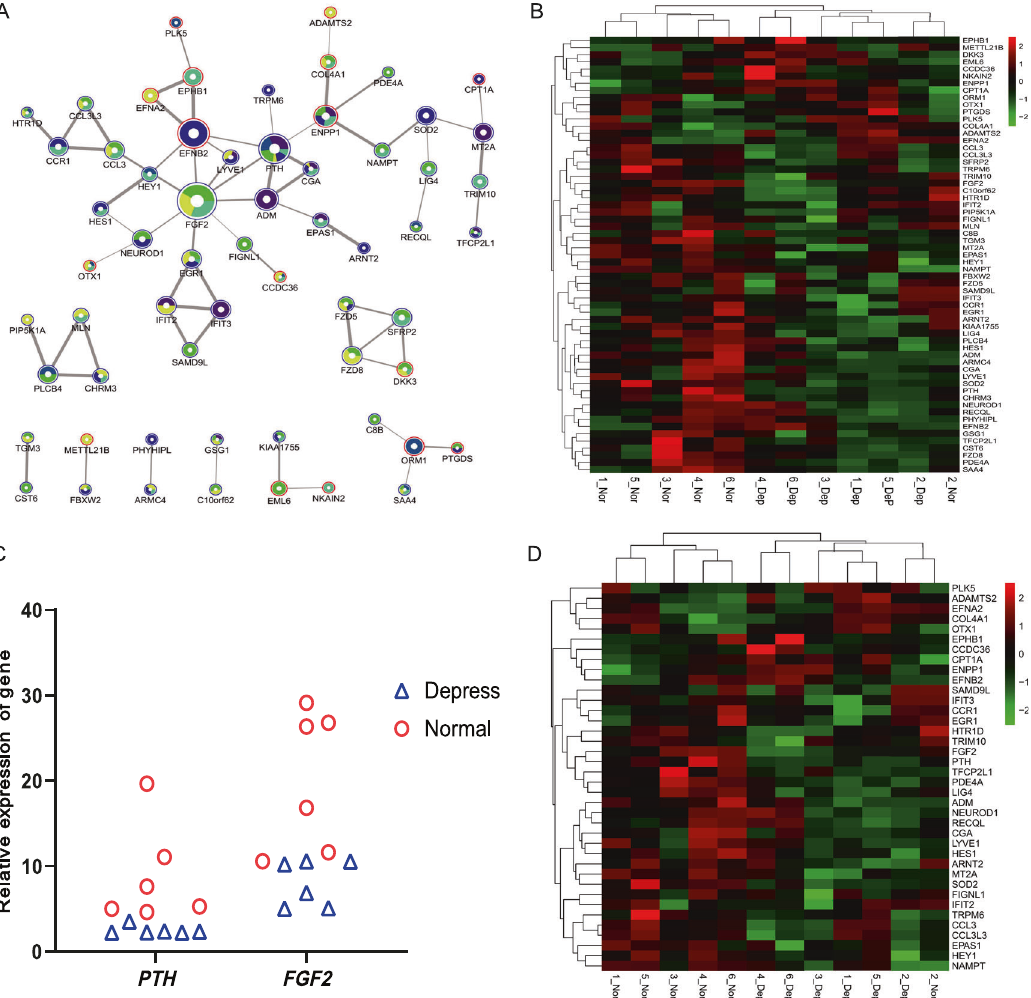
Fig. 2 Protein interaction network and gene expression heatmap of the genes in the networks. A Protein-protein interaction networks constructed by the all DEGs in the six sib-pairs. Six colors are used to represent six pairs of siblings, purple for the fi rst sib-pair, faint blue for the second sib-pair, green for the third sib-pair, yellow for the fourth sib-pair, dark blue for the fi fth sib-pair, and lake blue for the sixth sib-pair. The red edge represents the up-regulated gene, and the blue edge represents the down-regulated gene. Hub gene are FGF2 and PTH . B Expression heatmap and clustering of the genes in A. C Realtive expression of PTH and FGF2 in six sib-pairs. PTH is a signi fi cantly differentially expressed gene shared by six sib-pairs, while FGF2 only has a signi fi cant difference in 346 sib-pairs. D Expression heatmap and clustering of the genes in the subnetwork of PTH-FGF2 in